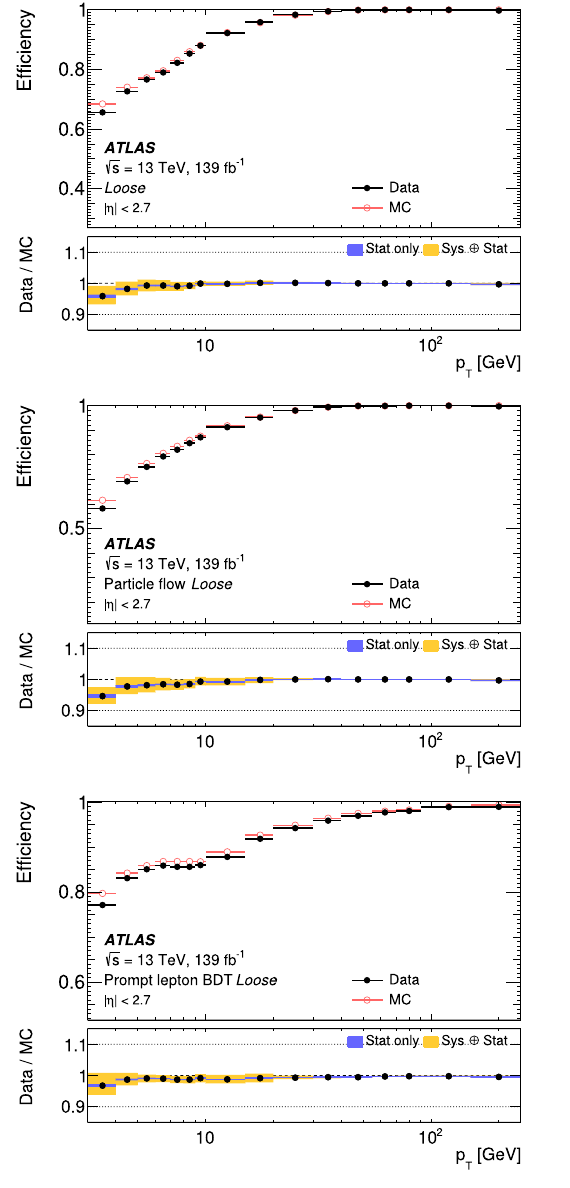
efficiency measurement is smaller than the size of the markers, and thus not displayed. The panel at the bottom shows the ratio of the measured to predicted efficiencies, with statistical and systematic uncertainties